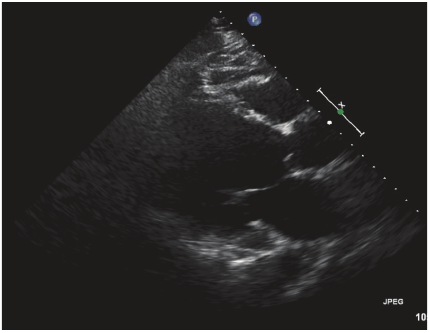
Figure 3: Echocardiogram showing dilated LV and EF of 10%.